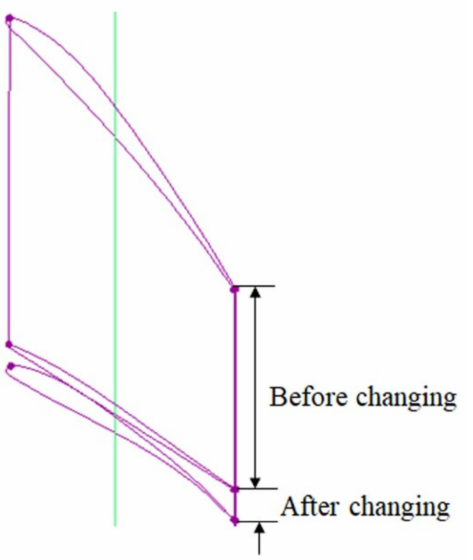
Figure 20. Guide vane attached to the generator side (short chord).